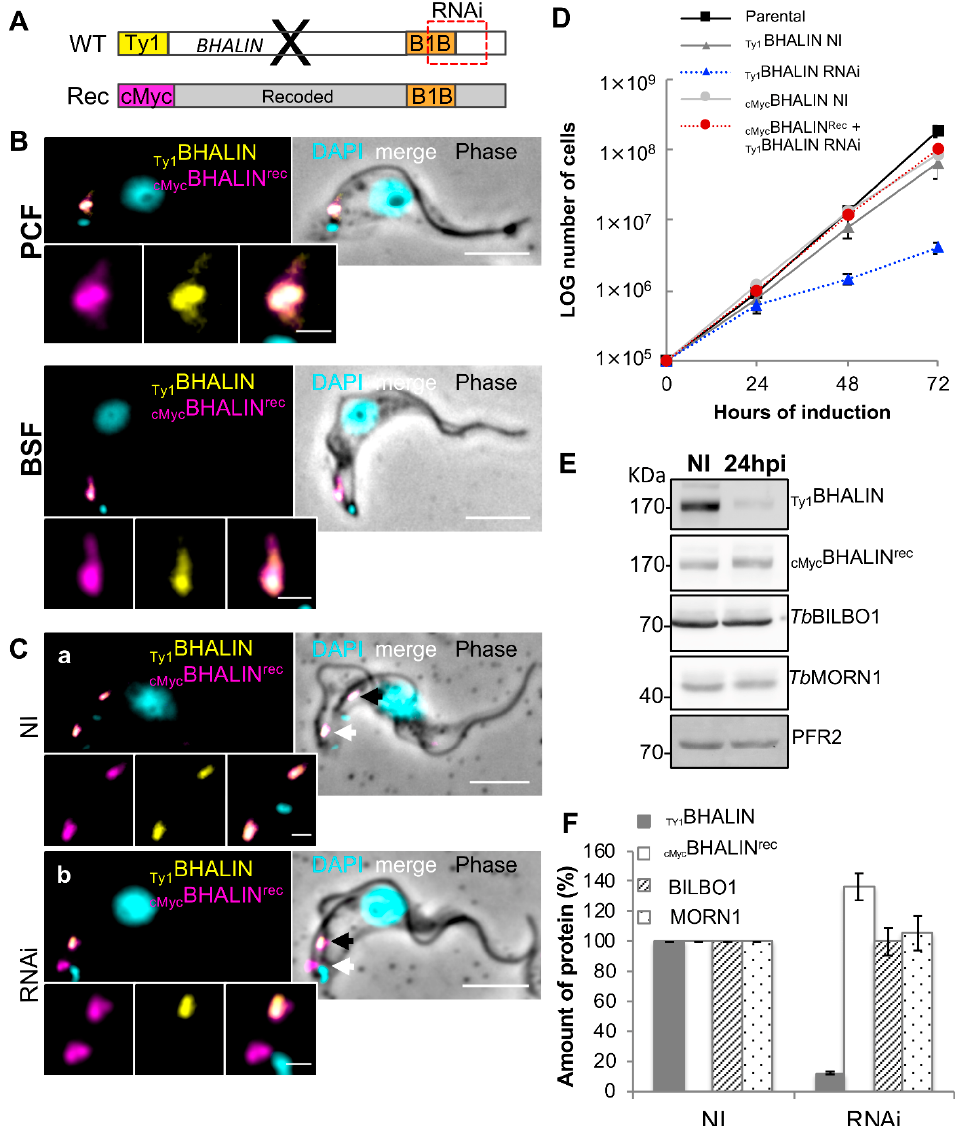
Figure 6. Full-length recoded BHALIN rescues the lethal RNAi phenotype in BSF. ( A ) Schematic to illustrate where Ty1 BHALIN was targeted by RNAi. It also shows the recoded full-length BHALIN . ( B ) Immunofluorescence labelling of cytoskeletons of PCF and BSF trypanosomes expressing Ty1 BHALIN (yellow) and cMyc BHALIN rec protein (magenta). The recoded protein targeted to the HC and exhibited the same location and shape as Ty1 BHALIN (yellow). ( C ) ( a ) IFA of a non-induced (NI) BSF trypanosome in the 2K1N cell cycle stage showing co-localisation of cMyc BHALIN rec (magenta) and the Ty1 BHALIN protein (yellow). The black arrow indicates the old hook complex and the white arrow indicates the new hook complex. ( b ) A BSF trypanosome in the 2K1N cell cycle stage after RNAi knockdown of untagged and tagged [ Ty1 BHALIN]) WT alleles for 24h, showing loss of tagged WT protein signal in the new complex but presence of the recoded cMc BHALIN rec in both complexes. ( D ) Growth curve showing that cMyc BHALIN rec expressing cells, (red circles), exhibited no growth defect after induction of RNAi against Ty1 -tagged and untagged alleles. Whilst the WT cell line containing untagged and Ty1 BHALIN ( Ty1 BHALIN-blue triangles) showed a notable growth defect from 24 hpi. Parental = the original non-modified or tagged cell line. ( E ) Western blot of RNAi resistant ( cMyc BHALIN rec ), (BSF trypanosomes before knockdown (NI) and 24 hpi (RNAi). Ty1 BHALIN protein probed with anti-Ty1 and cMyc BHALIN rec probed with anti-cMyc. Tb BILBO1 and Tb MORN1 were probed with their specific antibodies. PFR2 used as a loading control. ( F ) Quantification of Western blot from 3 separate inductions, of non-induced RNAi (NI) and 24 hpi (RNAi). Scale bars in C and D represent 5 µ m, inset = 1 µ